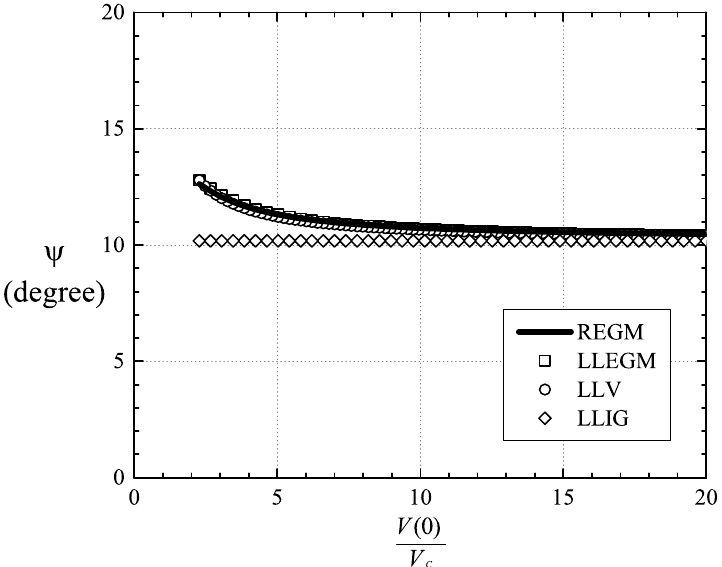
Figure 9. Scaled attitude angle vs. reference specific volume V (0)/ V c at T ref = 1.25 T c . The speed number Λ = 50 and the parameter δ =